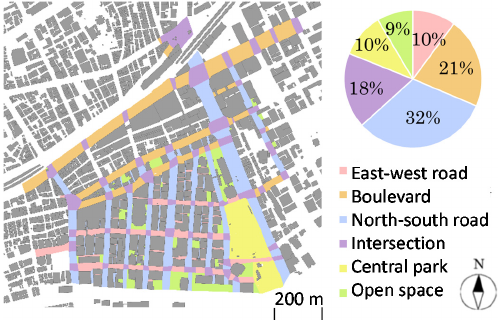
Figure 5. Classification of open space in the study area.